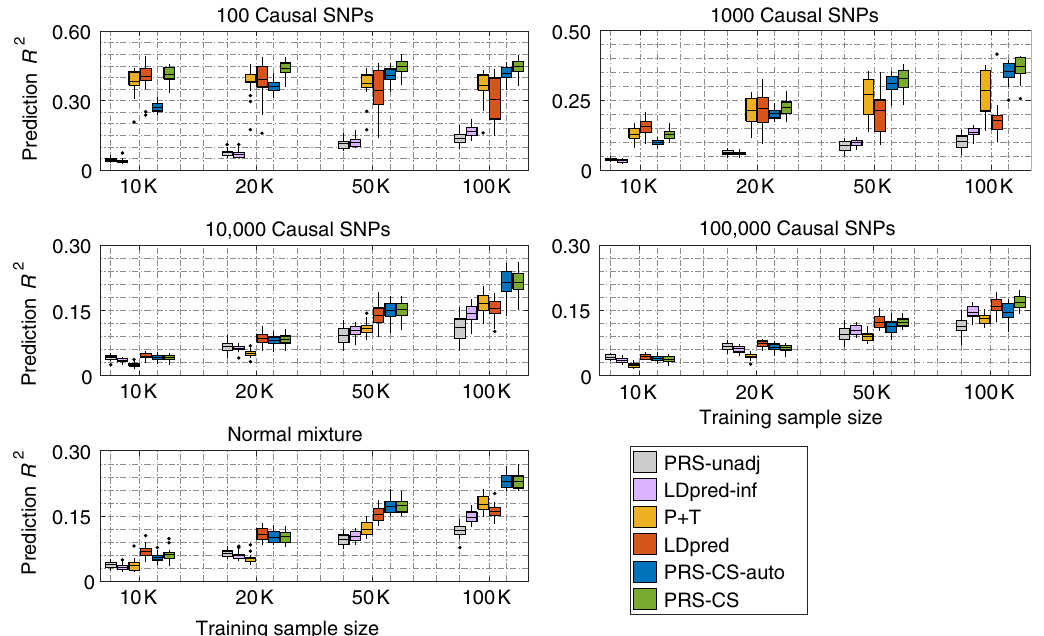
Fig. 1 Predictive performance of six polygenic prediction methods in simulation studies using a point-normal model and a normal mixture model. Heritability was fi xed at 0.5. The 1000 Genomes Project European sample was used as an external linkage disequilibrium (LD) reference panel. Tuning parameters ( P -value threshold in P + T, fraction of causal markers in LDpred, and global shrinkage parameter in PRS-CS) were selected in a validation data set. Prediction accuracy was quanti fi ed by R 2 between the observed and predicted traits in an independent testing set. The upper four panels correspond to the four genetic architectures (100, 1000, 10,000, and 100,000 causal variants) simulated using the point-normal model. The lower panel corresponds to the normal mixture model. Within each panel, results for four different training sample sizes (10,000, 20,000, 50,000, and 100,000) are shown. On each box, the central mark is the mean across 20 simulations, the edges of the box are the 25th and 75th percentiles, the whiskers extend to the most extreme data points that are not considered outliers, and the outliers are plotted